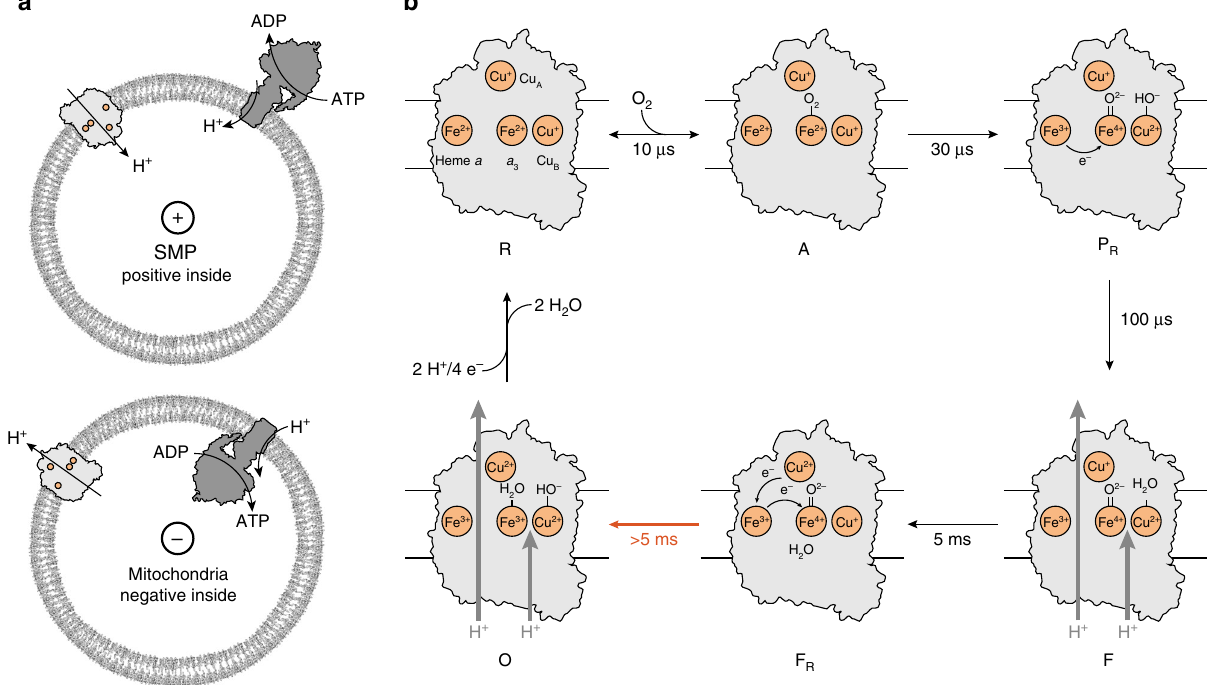
Fig. 1 Experimental system and model. a CytcO and ATP-synthase orientation in SMPs and mitochondria, respectively. b The reaction studied in this work. Upon initiation of the reaction by a light fl ash CO dissociates to form state R . Then, O 2 binds to the reduced Cyt c O after which the reaction proceeds as shown and described in the text. The data from this work suggest that the F R → O step is slowed/blocked by the electrochemical proton gradient (red arrow). The release of H 2 O is indicated in the O → R step, but one of the H 2 O molecules could be released earlier in the cycle. One of the protons taken up in this reaction is bound by a Tyr residue that is not explicitly drawn in the fi gure (the Tyr also donates a proton upon forming P R